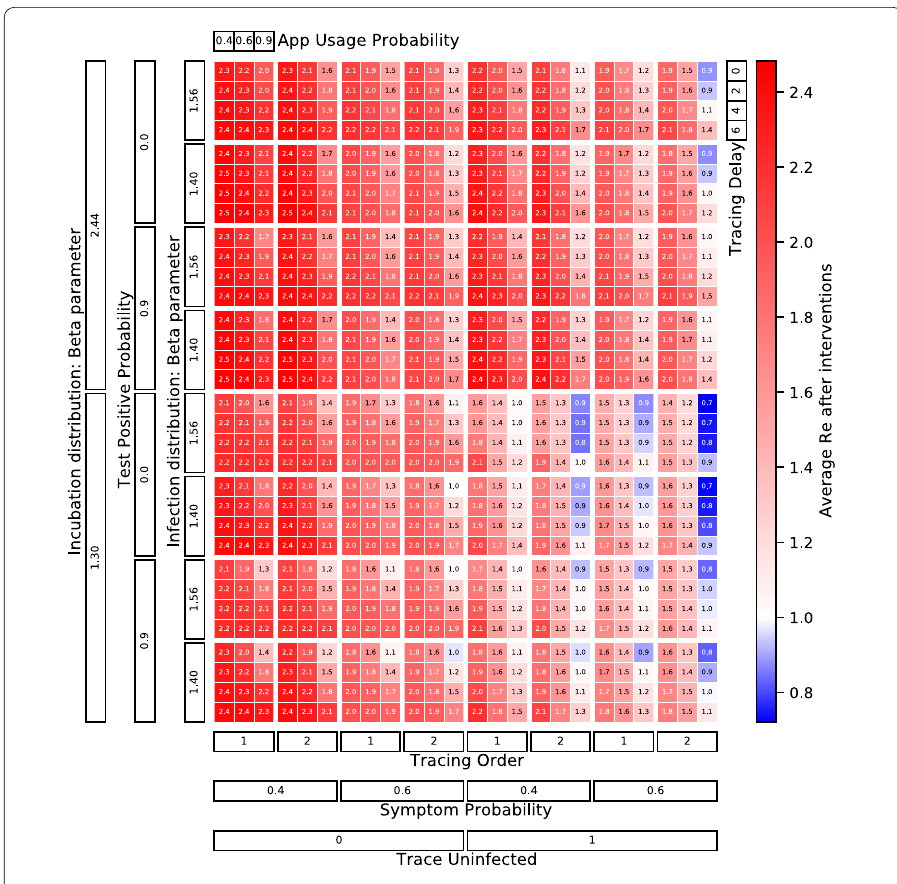
Figure 29 The effective reproductive number reached once interventions are turned on is shown for all combinations of parameters in the timing and delay parameter